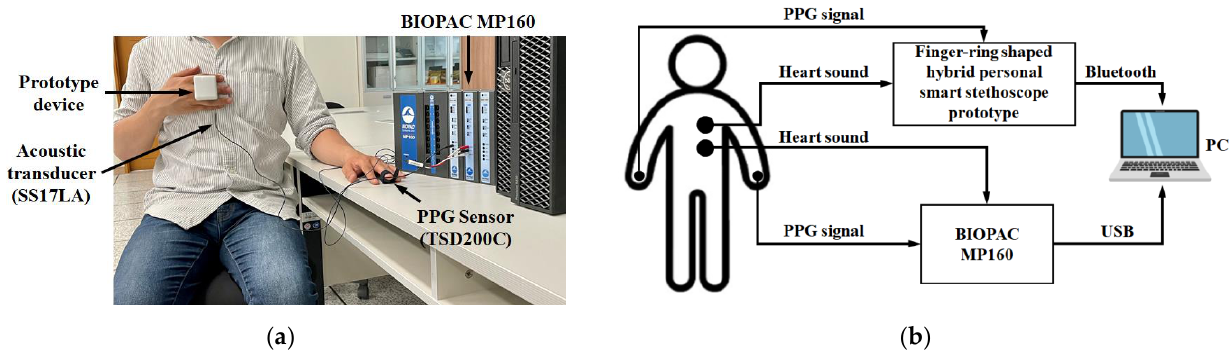
Figure 9. Pictures of the experimental setup for heart-sound and PPG-signal-data acquisition: ( a ) photo of a subject and measurement with the prototype device and MP160; ( b ) diagram of the experimental setup for data acquisition.